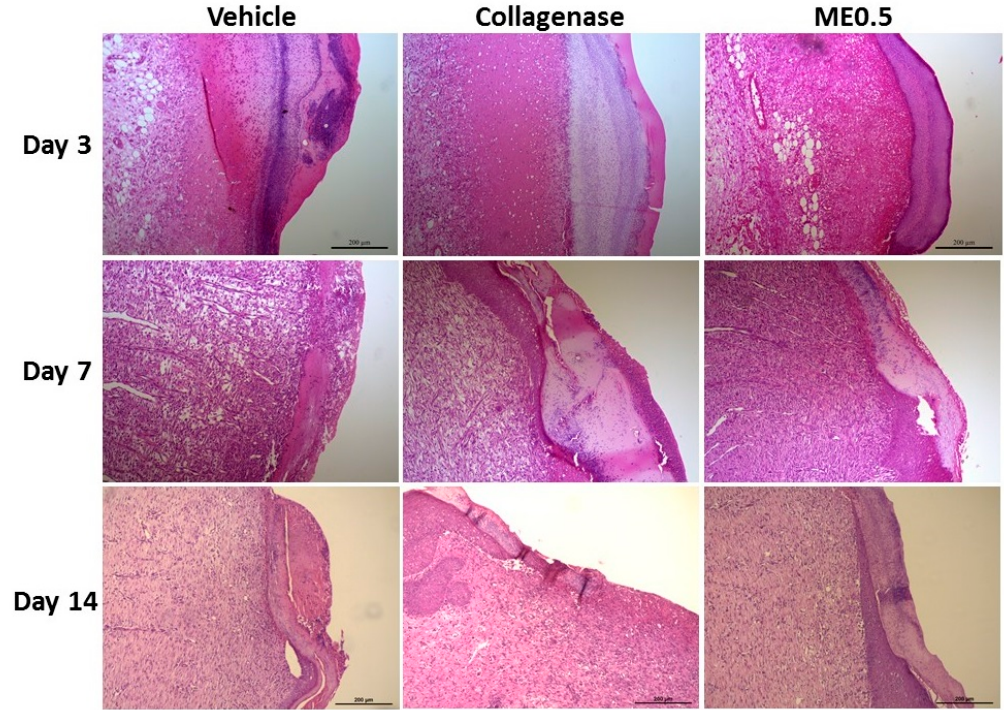
Figure 3. Representative histological sections of skin wounds after 3, 7, or 14 days of treatment with vehicle, collagenase cream, or ME0.5 (HE staining). Scale bar: 200 µm.